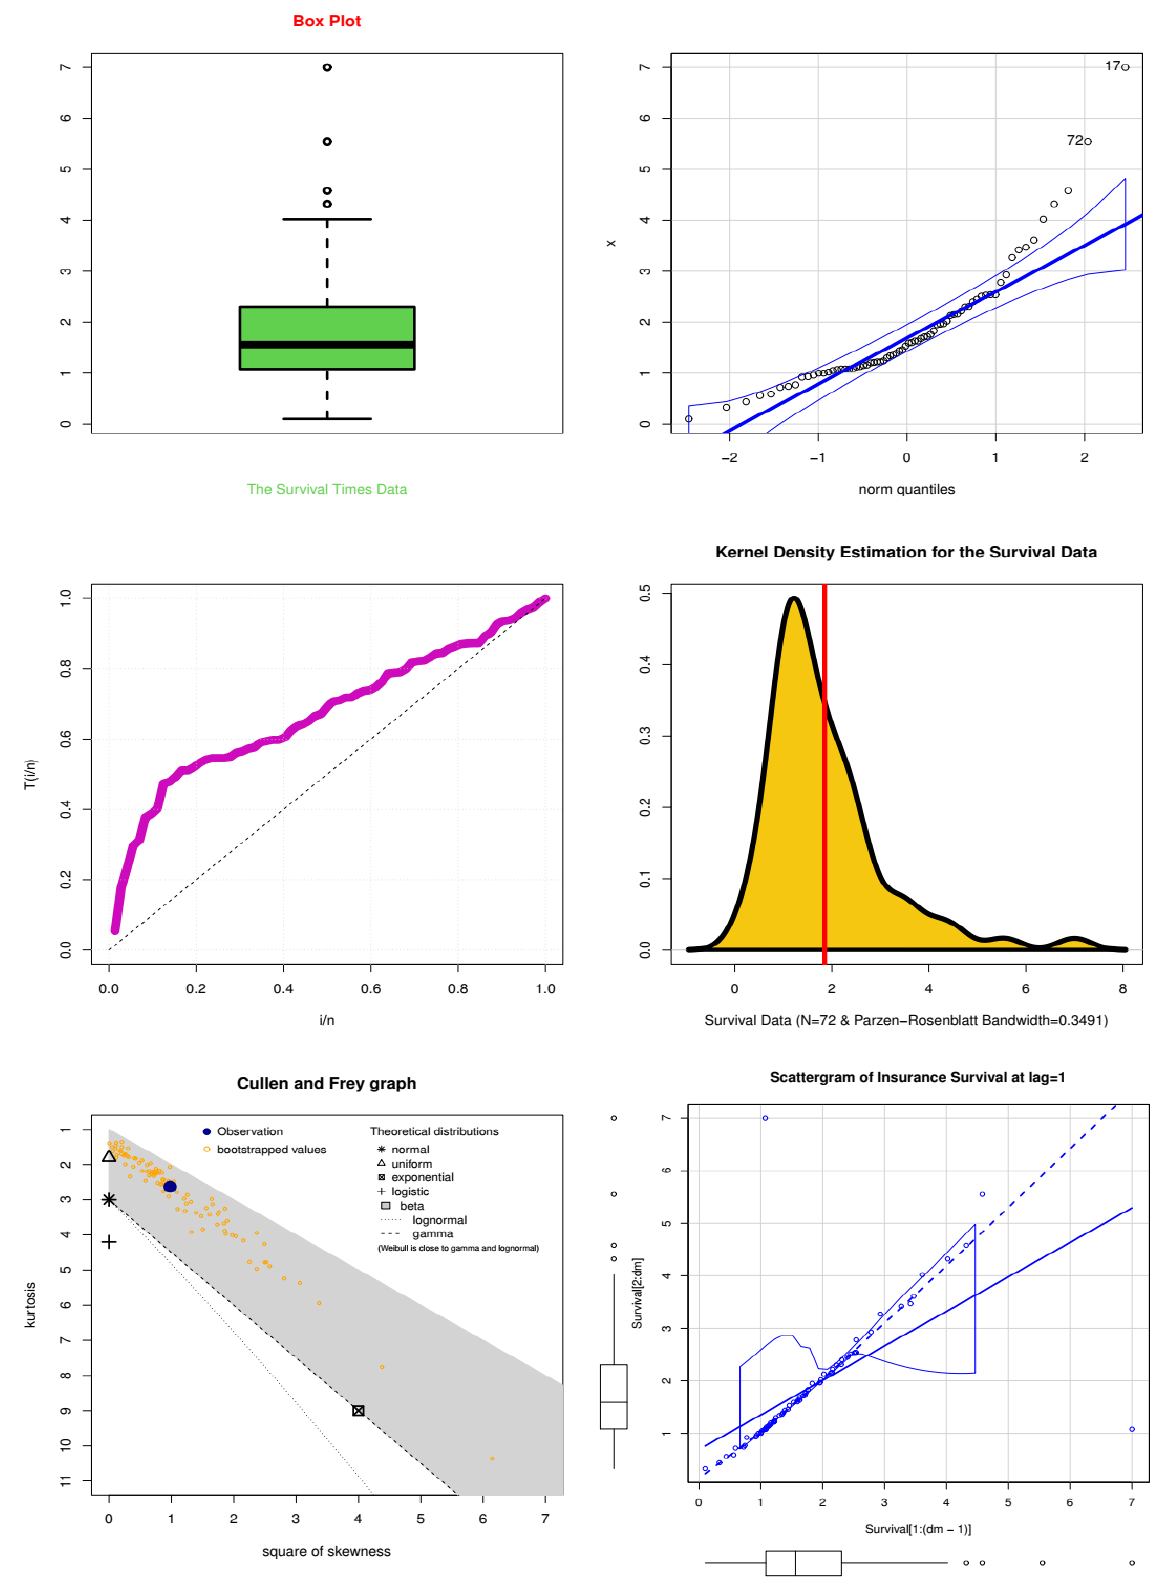
Figure 2. Box plot, Q-Q plot, TTT plot, nonparametric Kernel density estimation, Cullen and Frey, and scattergrams for the survival